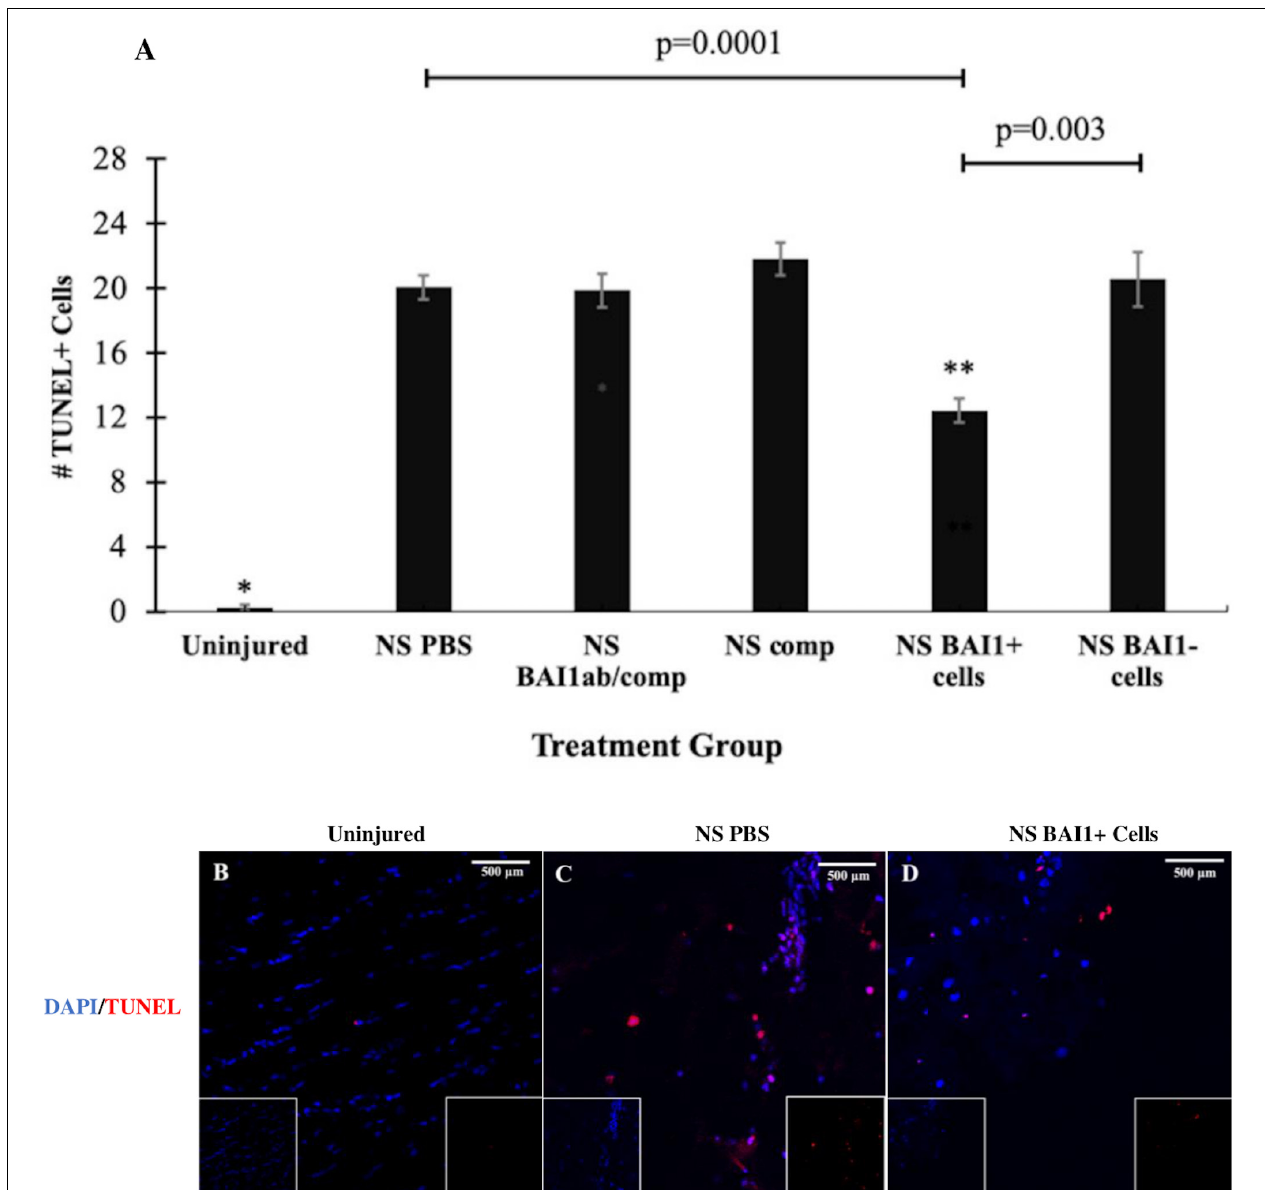
FIGURE 3 | Comparison of cell death before and after NS injury and with depletion or addition of BAI1+ cells. Six tissue sections from 3 to 6 animals per treatment group were stained with TUNEL reagents (red in B–D ). Nuclei were stained with DAPI (blue in B–D ). The number of TUNEL+ cells was counted within a 1 mm area lateral to NS tract or in a similar area in the uninjured brain. The results are the means ± SEM 24 h after NS with injection of PBS, the BAI1 mAb and complement (BAI1ab/comp), complement alone (comp), BAI1+ cells or BAI1– cells (A) . Significantly fewer TUNEL+ cells were present in uninjured tissue than the other treatment groups ( ∗ p = 0.00001). NS injury significantly increased the number of TUNEL+ cells in all treatment groups ( p < 0.05). Injection of BAI1+ cells isolated from the brains of other animals significantly reduced the number of TUNEL+ cells compared to all other groups ( ∗∗ p < 0.05). The numbers of TUNEL+ cells were similar in brains injected with PBS, BAI1 and complement (BAI1Ab/comp), and complement alone (Comp). Panels (B–D) are photographs of TUNEL and DAPI labeling in the parietal cortex of the uninjured brain and NS injured brains injected with PBS or BAI1+ cells. Unmerged images are shown as insets at the bottom of the photographs of merged images. TUNEL+ cells were rare in the uninjured brain (B) . Fewer TUNEL+ cells were observed after injecting BAI1+ cells (D) than in those injected with PBS (C)